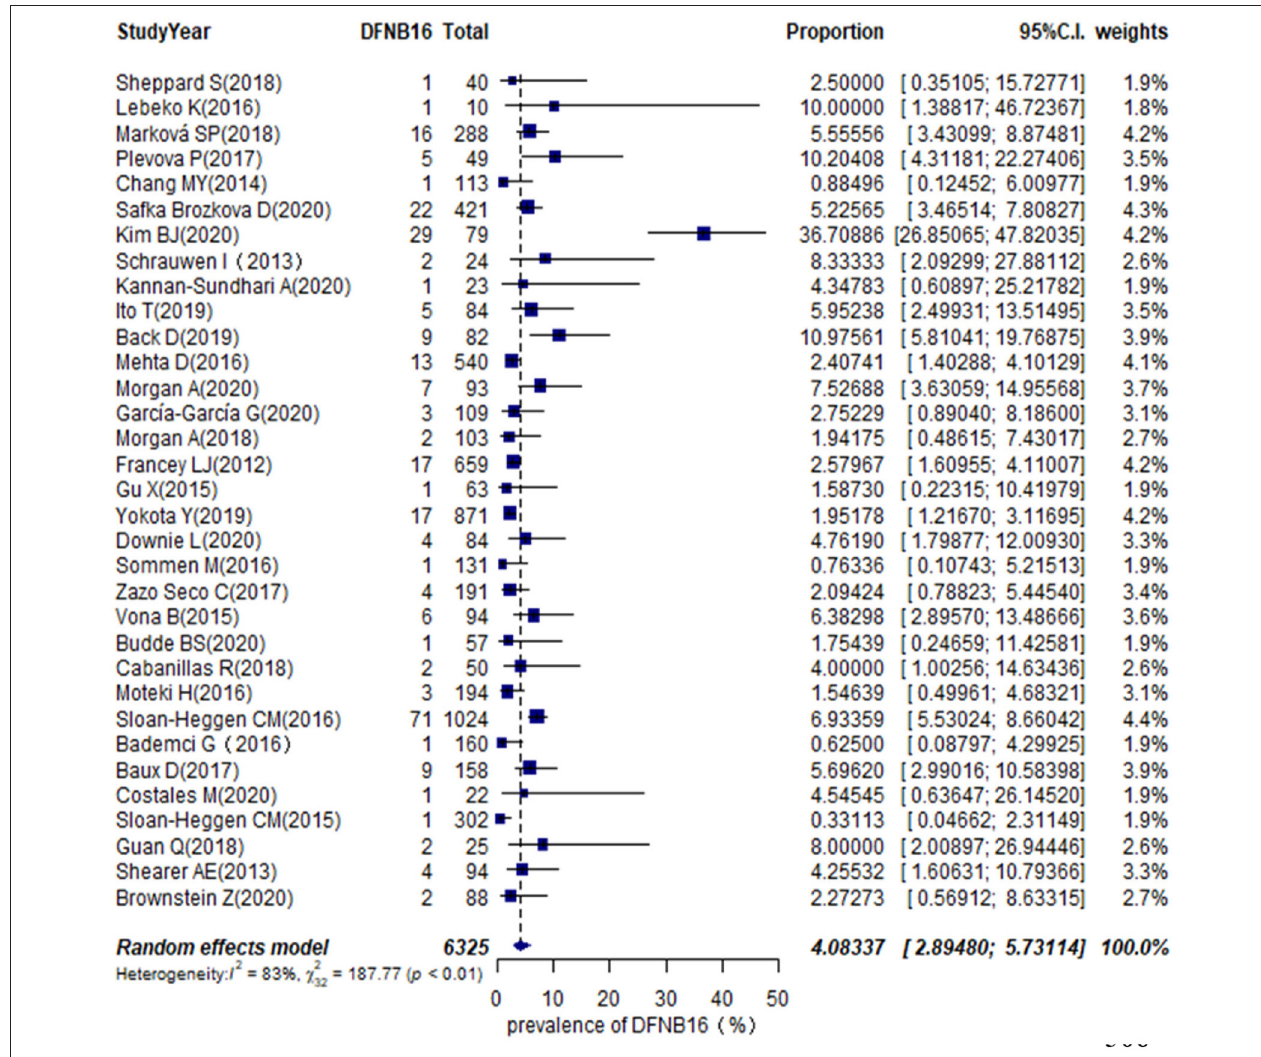
FIGURE 2 | The global prevalence of DFNB16 in GJB2-negative hearing impaired (HI) patients.